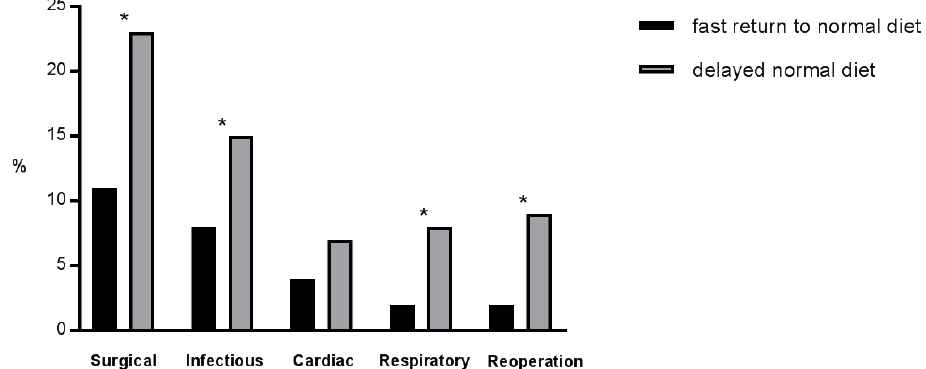
Figure 3. Comparison of surgical, infectious, cardiovascular, and respiratory complications and reoperation rate among patients with fast return to normal dietary intake (within POD 2, black bars) and patients with delayed tolerance of normal diet beyond POD 2 (grey bars). * Indicates statistical significance ( p < 0.05).